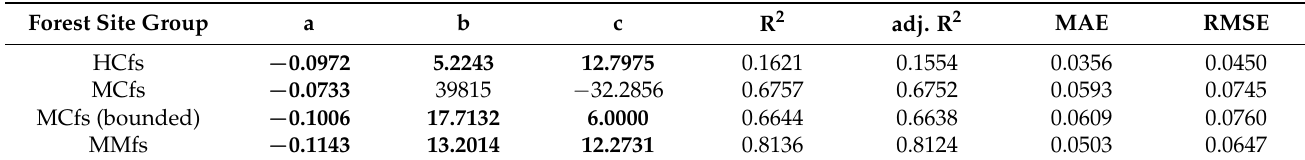
Table 3. The parameters and statistics of fitted Gompertz function to model the growth of the height for a given initial tree height. Statistically significant parameters of the function are in bold ( p -value < 0.05).